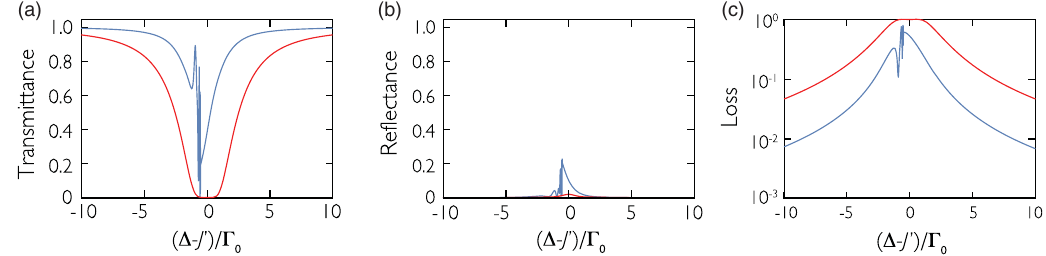
= 4 ( k 1 d ¼ π = 2 ). (a) Transmittance, D D